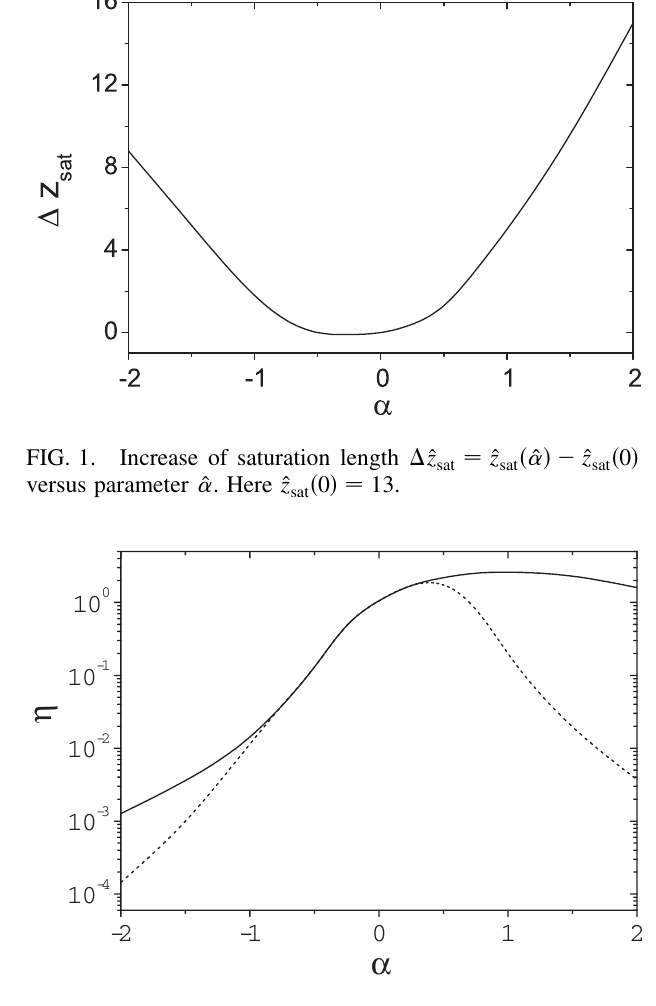
FIG. 2. Normalized output power versus parameter ^ (cid:4) .